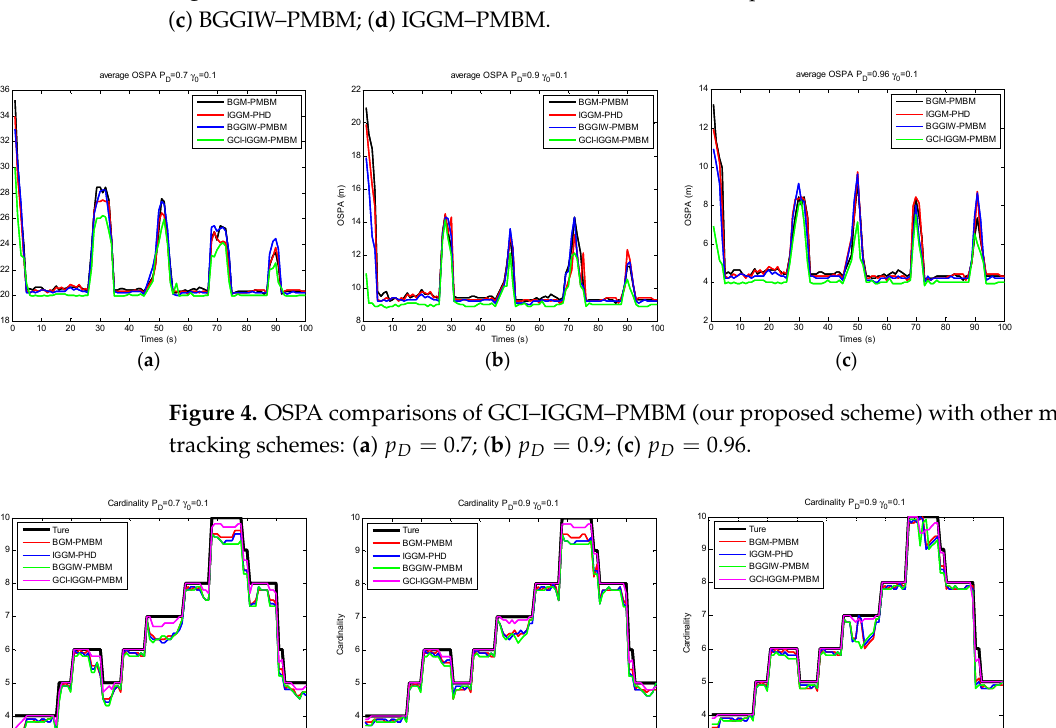
( c ) Figure 6. Performance comparisons of GCI–IGGM–PMBM with other multitarget tracking schemes with unknown detection probability: ( a ) detection probability estimation; ( b ) OSPA estimation; ( c ) cardinality estimation. ( a ) ( b )